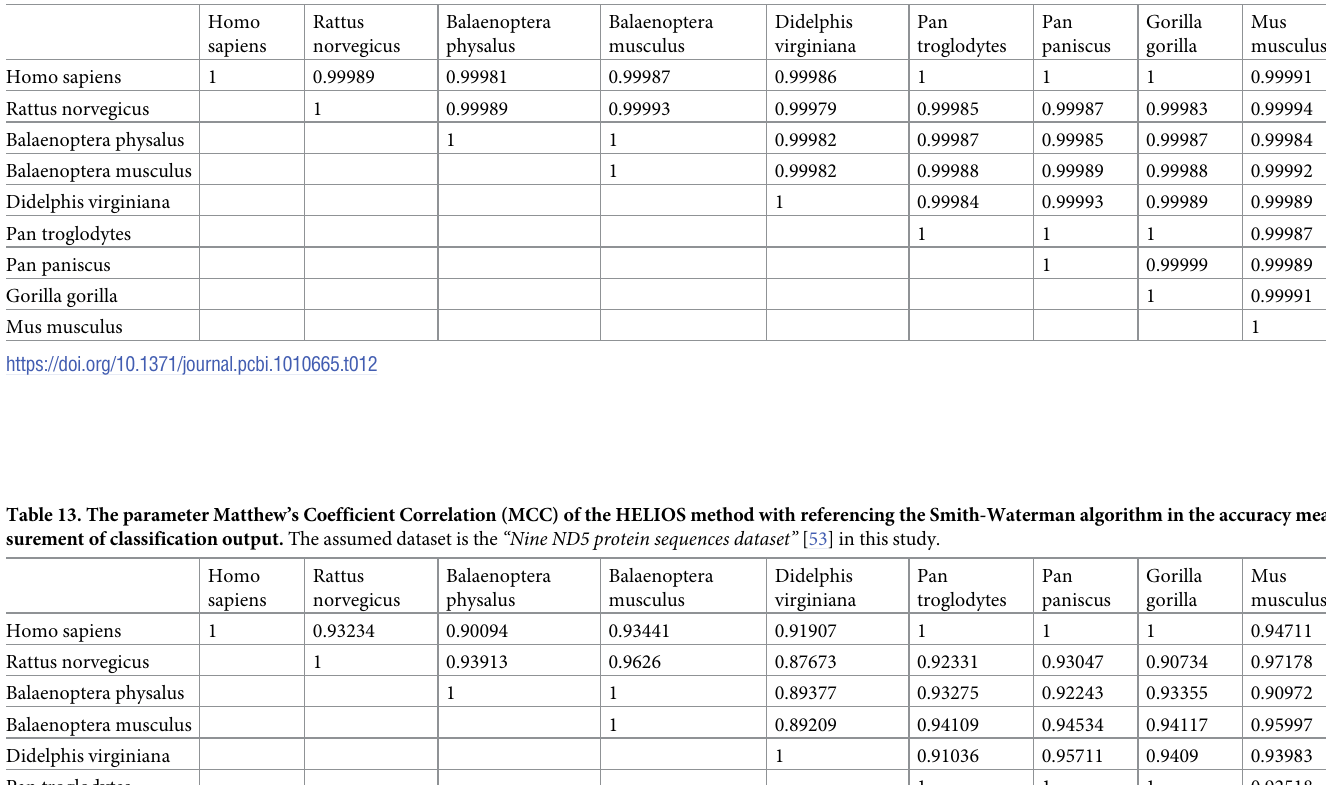
Table 12. The parameter Negative Predictive Value (NPV) of the HELIOS method with referencing the Smith-Waterman algorithm in the accuracy measurement of classification output. The assumed dataset is the “Nine ND5 protein sequences dataset” [53] in this study.